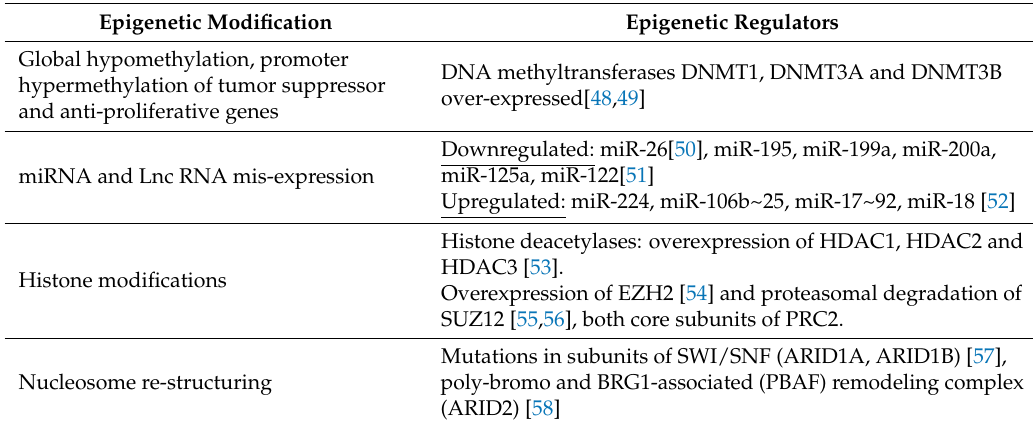
Table 2. Epigenetic Modifications and Regulators in Hepatocellular Carcinoma